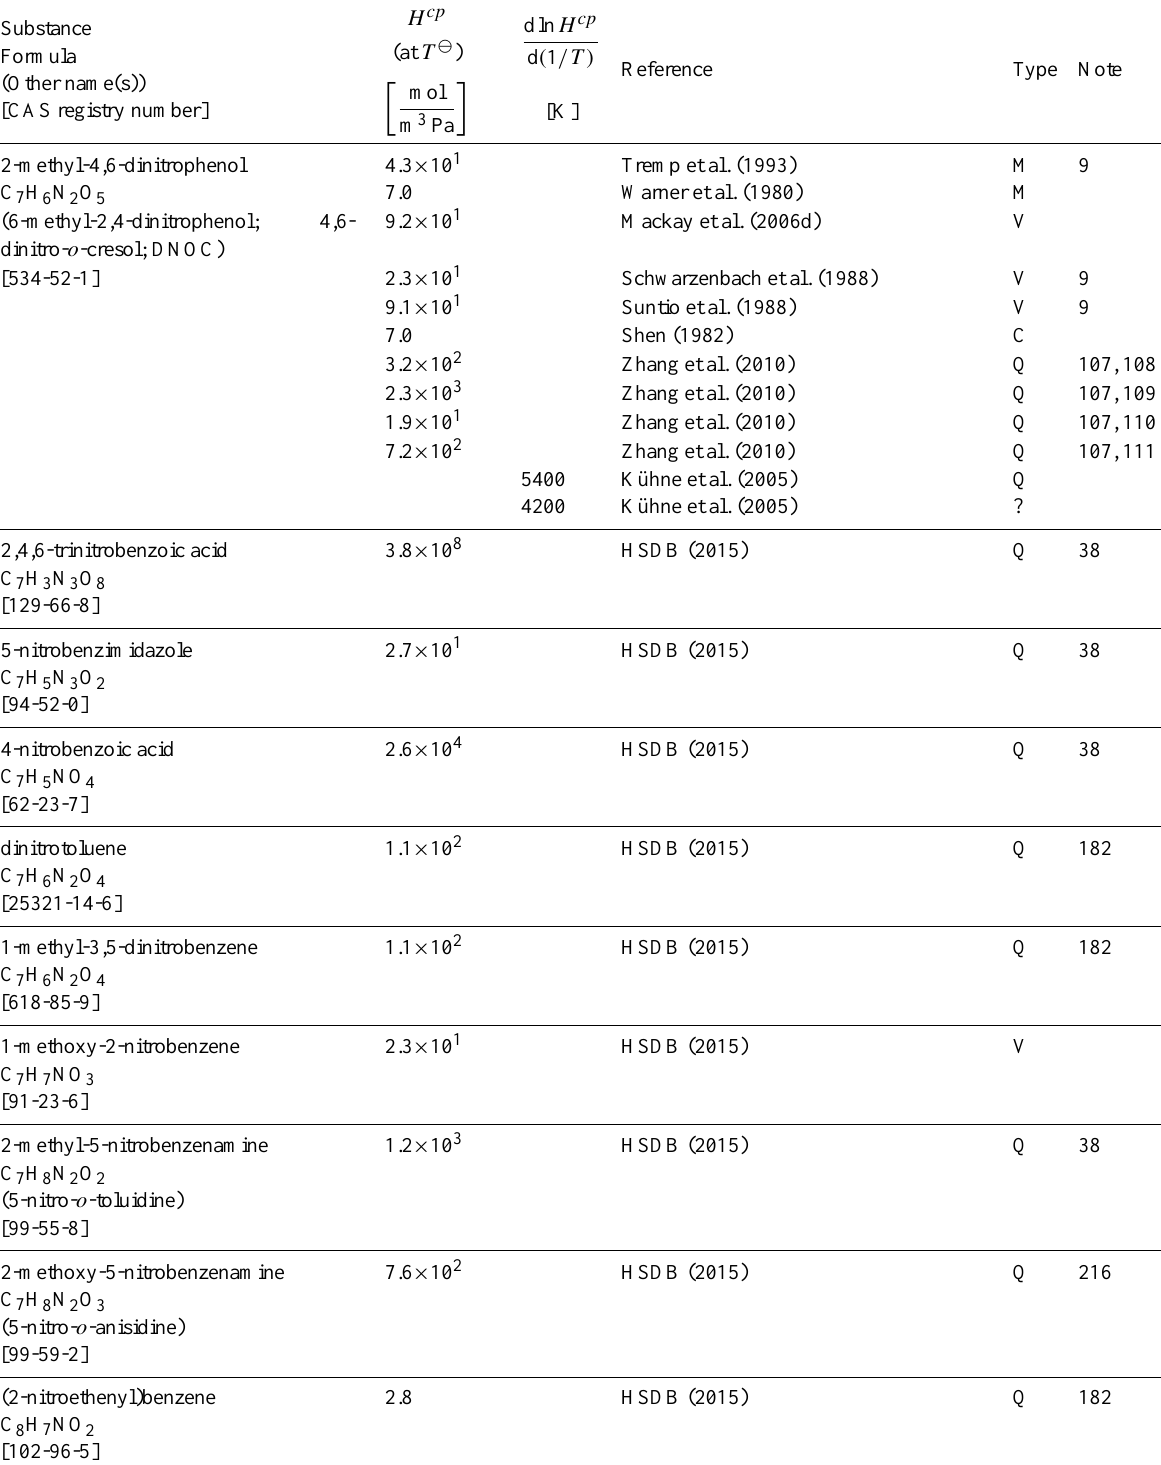
Table 6: Henry’s law constants for water as solvent